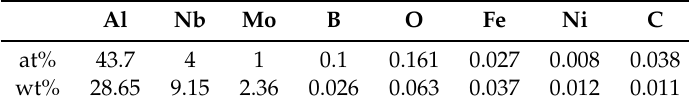
Table 1. Composition of the TNM-B1 ingots as specified by